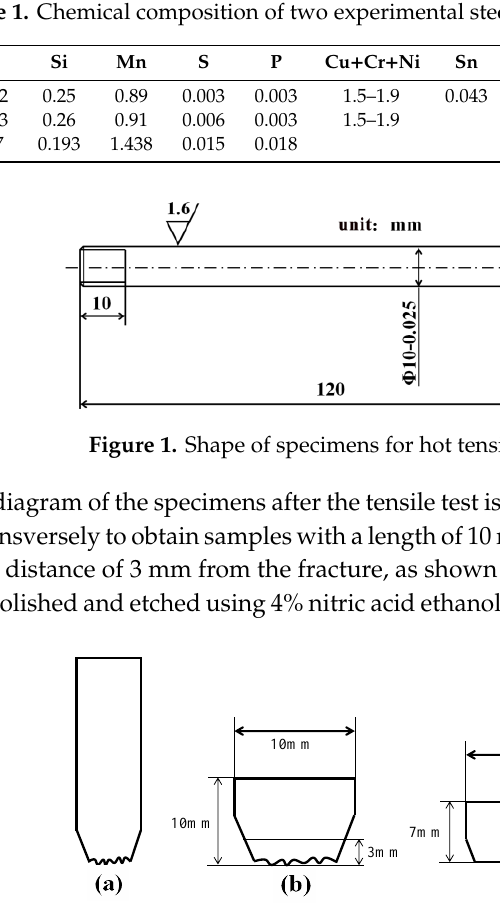
Figure 2. Schematic diagrams of specimen processing showing ( a ) The specimen after fracture; ( b ) the specimen near the fracture surface; ( c ) the final specimen used for microstructure observation.